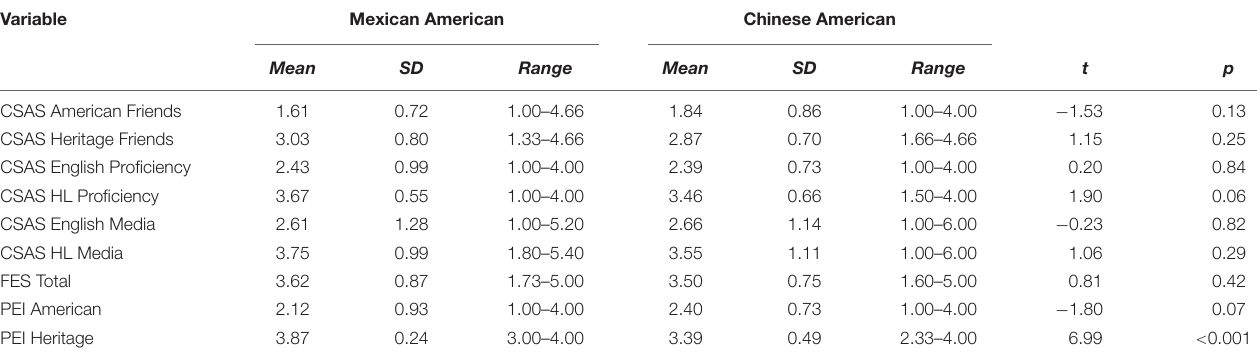
TABLE 2 | Parental acculturation scores by Mexican American and Chinese American. Variable